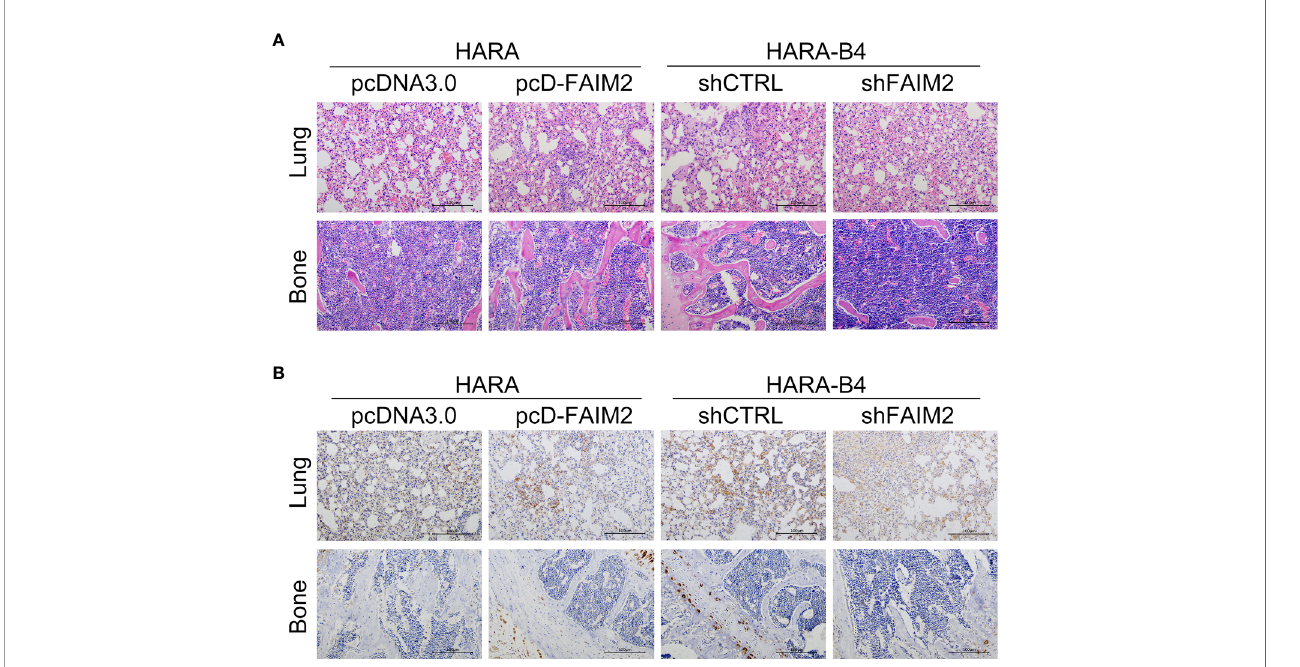
FIGURE 8 | FAIM2 participated in regulating NSCLC bone metastasis in vivo . An in vivo NSCLC bone metastasis model was established. (A) The lung and bone tissues were collected and stained with H&E to observe changes in the microstructure. (B) The lung and bone tissues were collected to test for FAIM2 expression via